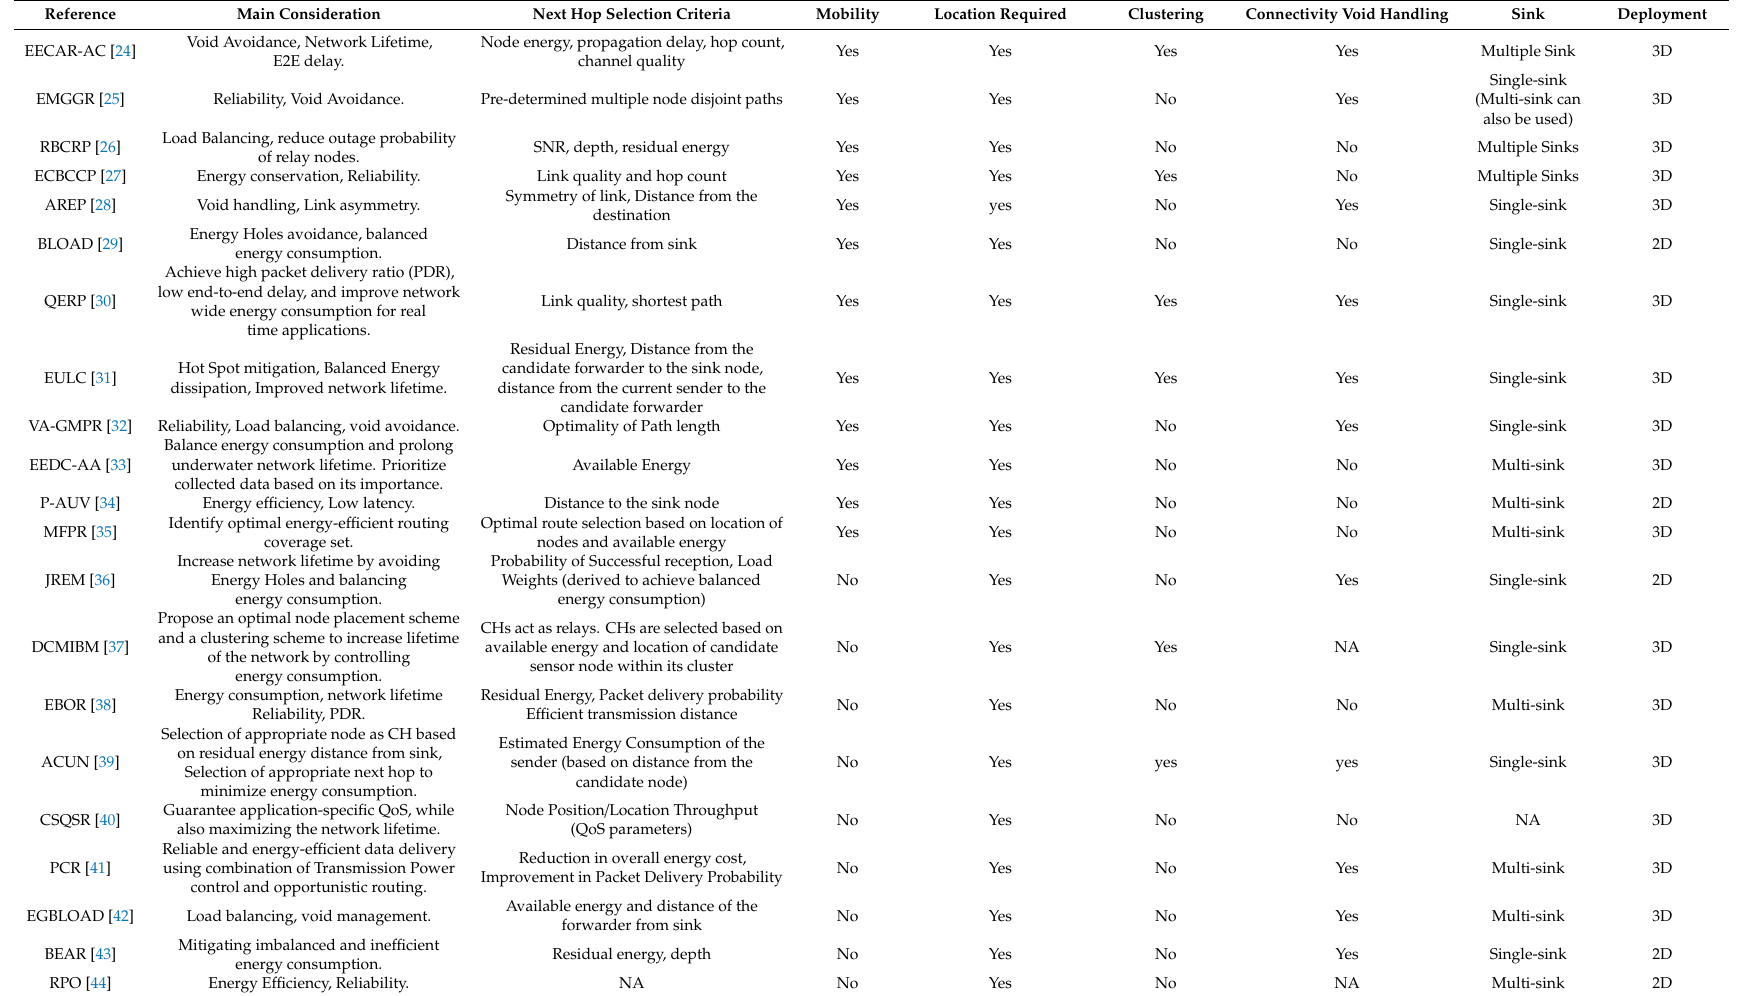
Table 1. Survey of localization-based routing